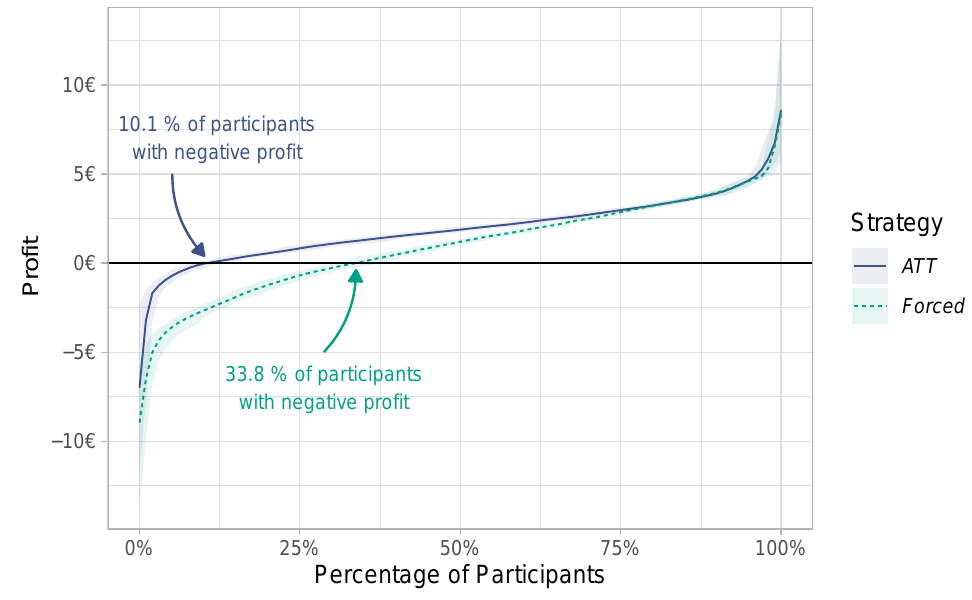
Figure 6. Profit distribution under the ATT and Forced strategy in Scenario